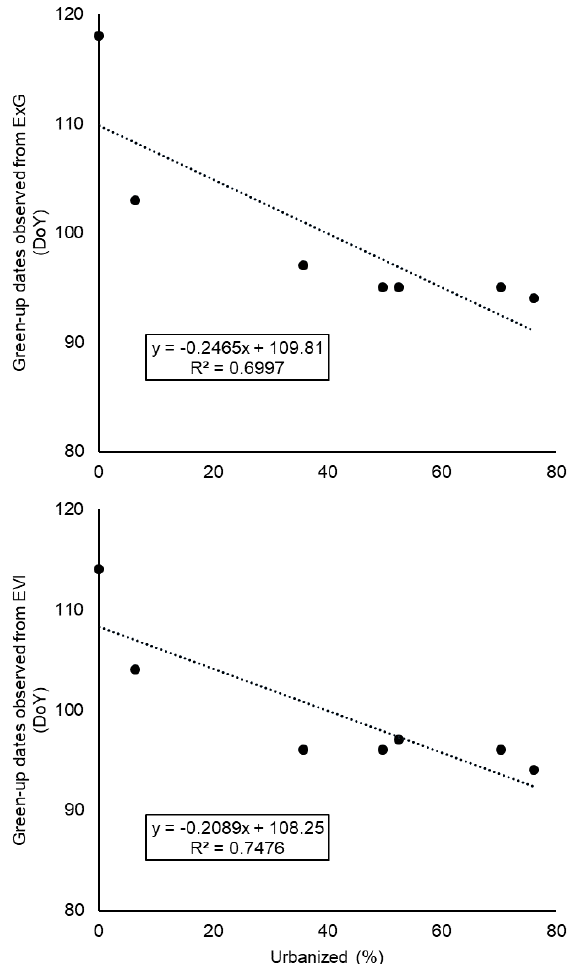
Figure 5. Relationship between urbanization ratio and green-up dates derived from ExG ( upper ) and EVI ( lower ) ( p < 0.05).